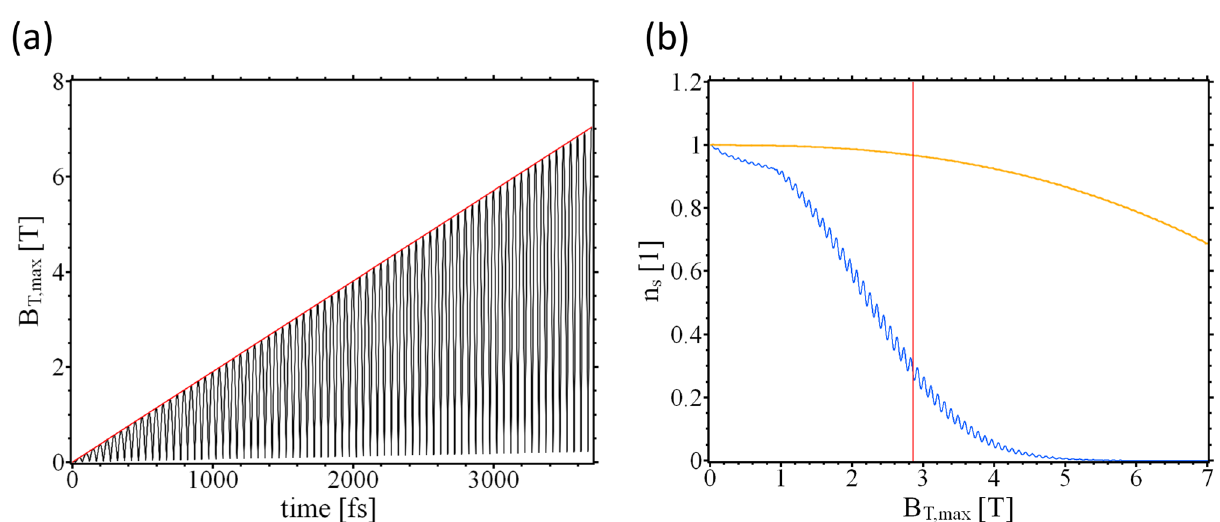
Figure 3. ( a ) Local maximum value of B T,max (black curve) and its envelope (red curve) in the sample over time. ( b ) The minimum (blue curve) and the maximum value (orange curve) of the local density of Cooper pairs n s over the envolop of B T,max displayed in ( a